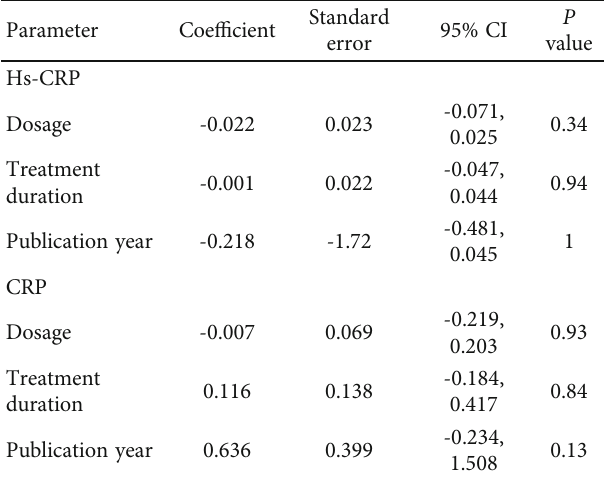
Figure 6: Random e ff ects metaregression plots of the association between WMD of hs-CRP, CRP, and statin administration based on (a) hs- CRP (dosage), (b) hs-CRP (publication year), (c) CRP (dosage), and (d) CRP (treatment duration). Table 3: Findings from metaregression analysis on the e ff ects of statin therapy on hs-CRP and CRP